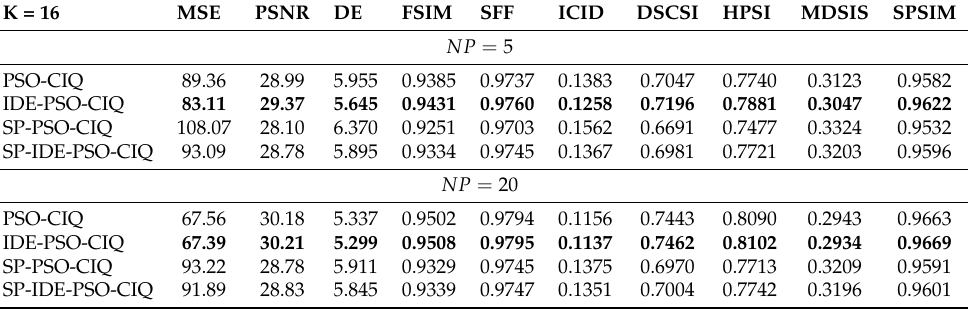
Table 3. Comparison of pixel and superpixel versions of PSO-CIQ and IDE-PSO-CIQ ( K = 16).